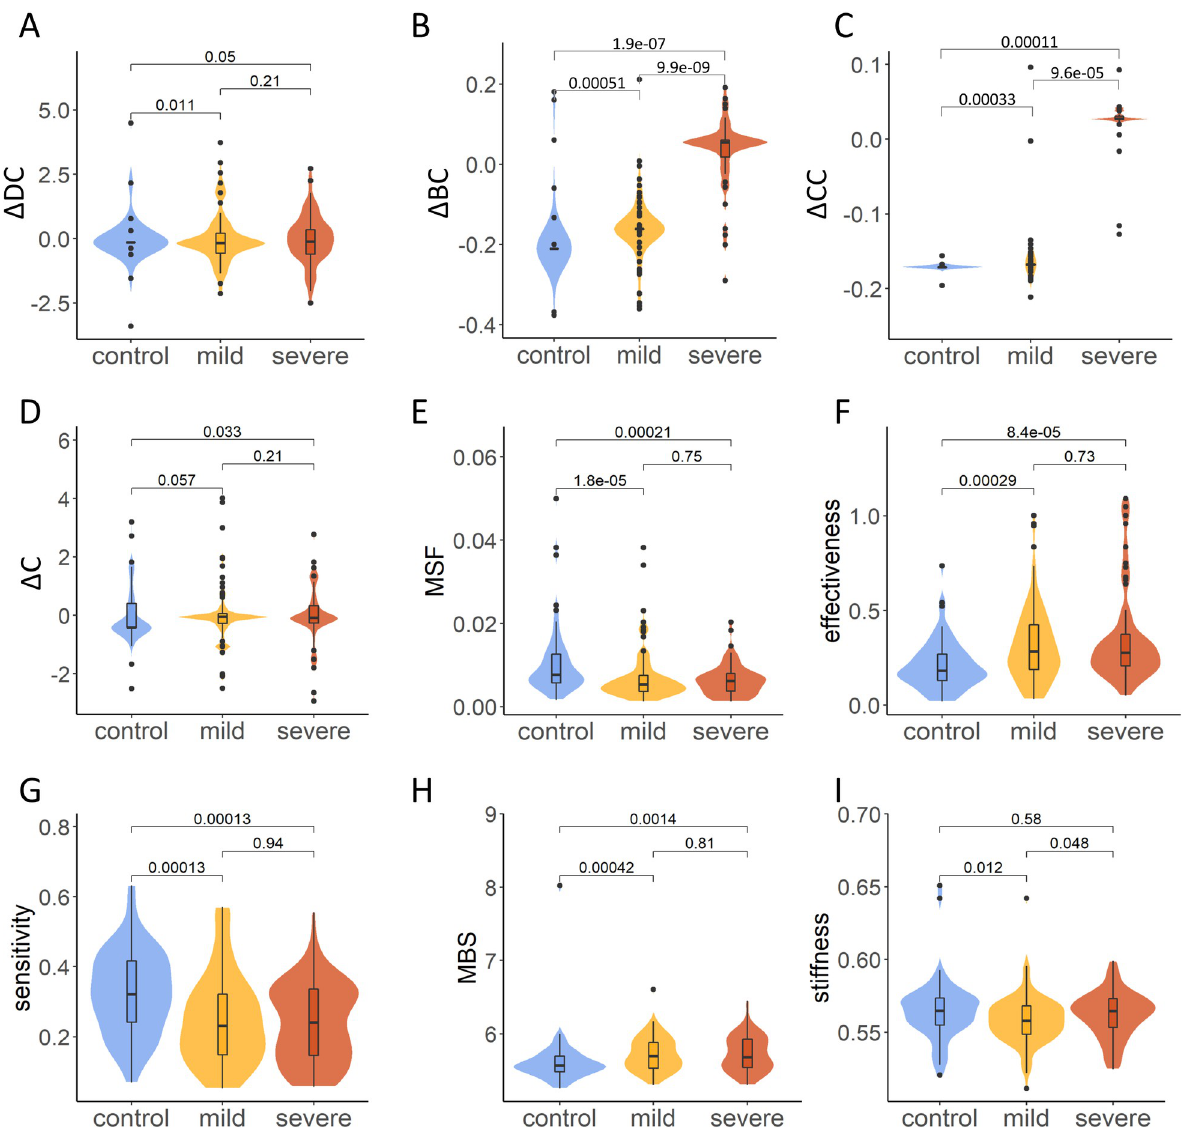
Fig 6. Comparison of the change of four network centralities and five dynamics-based parameters, including (A) Δ DC, (B) Δ BC, (C) Δ CC, (D) Δ C, (E) MSF, (F) effectiveness, (G) sensitivity, (H) MBS, and (I) stiffness, among mutations in the control, mild, and severe groups by Wilcoxon signed ranked